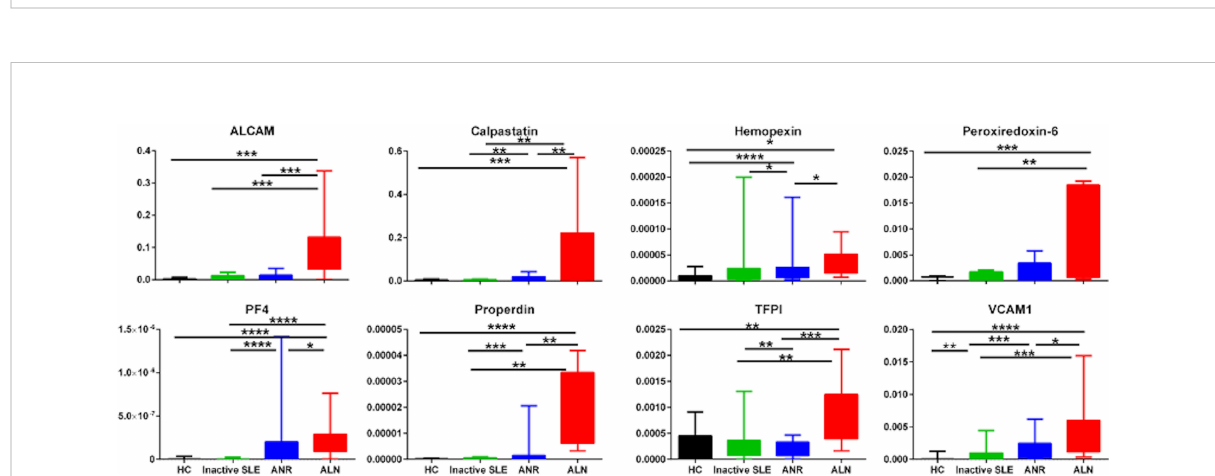
FIGURE 3 Fractional Excretion ratios of eight protein biomarkers in SLE patients and controls. Fractional excretion (FE) ratios of all 8 biomarker proteins were calculated by dividing the urine biomarker levels by the corresponding serum biomarker levels, after normalizing both against urine or serum creatinine, respectively. The Y axes show the values of the fractional excretion ratios of studied biomarkers (inter-quartile and range), while the X axes display the 4 groups interrogated (12 healthy controls; 12 inactive SLE; 12 active non-renal disease; 12 active renal disease). * = P<0.05, ** = P<0.01, *** = P<0.001, **** =